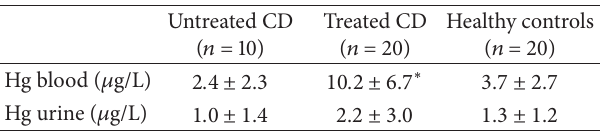
Table 2: Urinary and blood mercury (Hg) levels in celiac patients and healthy controls. Untreated